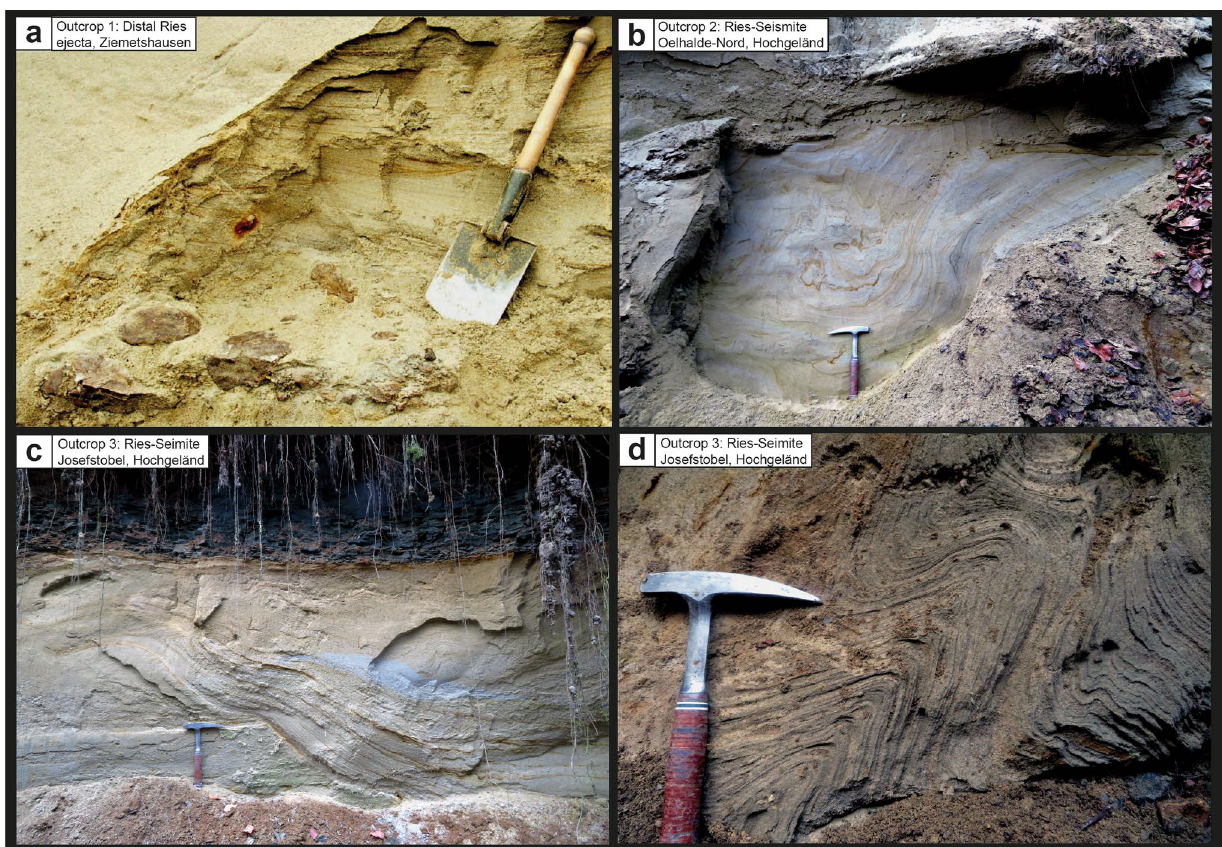
Figure 6. Photographs of the most impressive details of the Ries seismite and distal Ries ejecta that caps the Ries seismite from the outcrops discussed in the present study. ( a ) Primary (in situ deposited) horizon of distal Ries ejecta with angular Upper Jurassic limestone components from the former sandpit Ziemetshausen (photographs: a was taken by Peter Bockstaller, Schopfheim, in 2005; b – d taken by V.J.S. in 2020–2021, spade and hammer for scale). ( b ) Slump with internal convolute bedding in the Ries seismite from the Tobel Oelhalde- Nord (Hochgeländ); ( c ) Thrust fault-like slump in the Ries seismite from the Josefstobel (Hochgeländ plateau south of Biberach an der Riß); ( d ) Distinct fault- and fold-like structures in convolute bedding in the lower (Ries) seismite horizon from the Josefstobel (Hochgeländ plateau south of Biberach an der